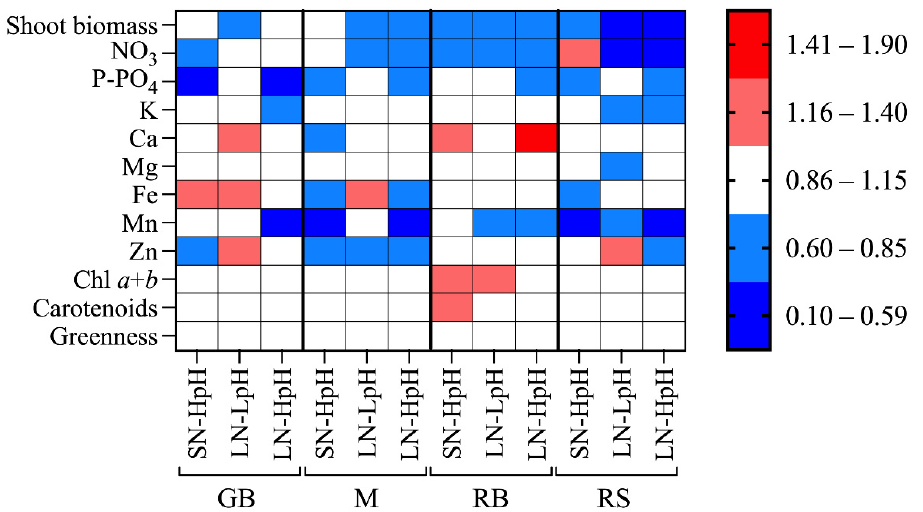
Figure 5. Heatmaps with yield and quality parameters of green basil (GB), mint (M), red basil (RB), and rocket salad (RS). Data are presented as the ratio of average values of treatment and control groups (SN-LpH). SN-HpH = standard nutrient concentration and high pH; LN-LpH = low nutrient concentration and standard pH; and LN-HpH = low nutrient concentration and high pH.